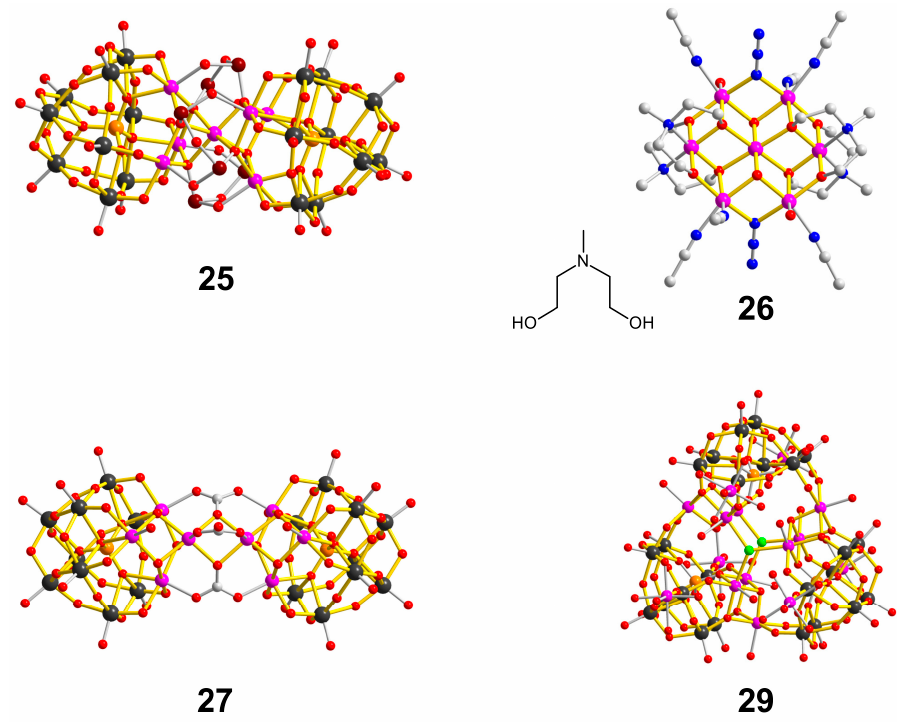
Figure 9. Structures of complexes 25 – 27 , and 29 (for 25 , 27 , and 29 cationic counterions are omitted) . Color scheme: Co, pink; W, black; As, dark red; Si, orange; Cl, green; O, red; N, blue.